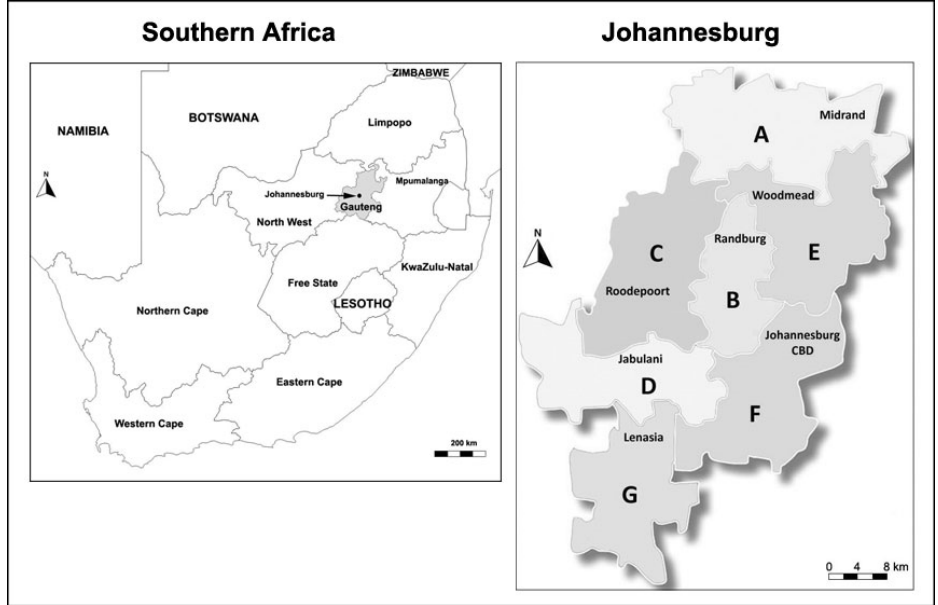
Figure 1. Geographical location of Johannesburg and the different regions of this city. (A=Region A; B=Region B; C=Region C; D=Region D; E=Region E; F=Region F; and G=Region G).